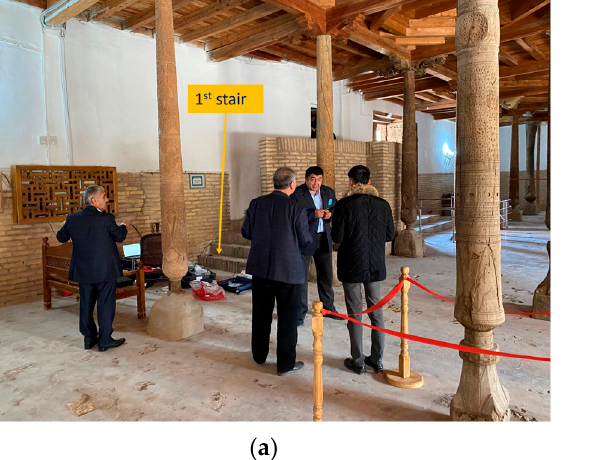
Figure 7. Starting stair and the procedure for the angle measurement of each stair: ( a ) view of the first stair; ( b ) schematic of the angle measurement.